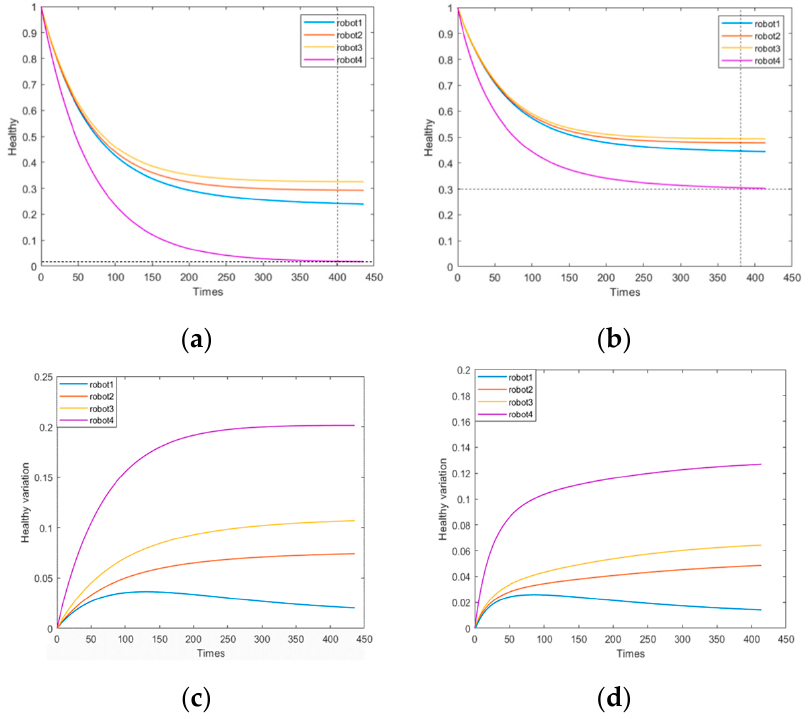
( d ) Figure 13. Comparison before and after adding HOM in the third scenario: ( a ) h i ( t ) of robots under normal conditions; ( b ) h i ( t ) of robots under HOM; ( c ) e i ( t ) under normal situations; ( d ) e i ( t ) under HOM. As can be seen from Figure 13c, if there is no health optimization management, the differences in robot health diverge with time and are large compared with the average value, while in Figure 13d, the differences are small. 4.2.4. Due to the Abnormal Fault of the Motor of a Single Robot, the Power Consumption Rate of the Robot Increases Figure 14a,b describes the results of the fourth case, in which each robot is initialized